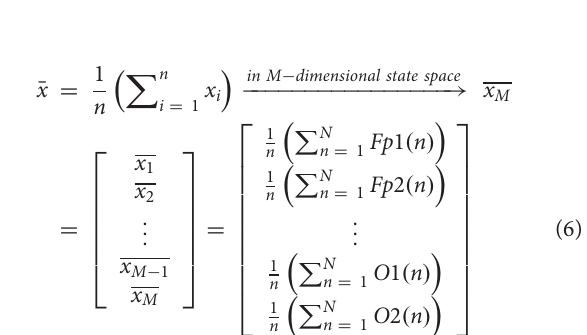
FIGURE 8 | The changes in entropy (h) against the number of symbols (S). (h) monotonically was reduced with increasing the amount of S and becomes less than ε h when S =